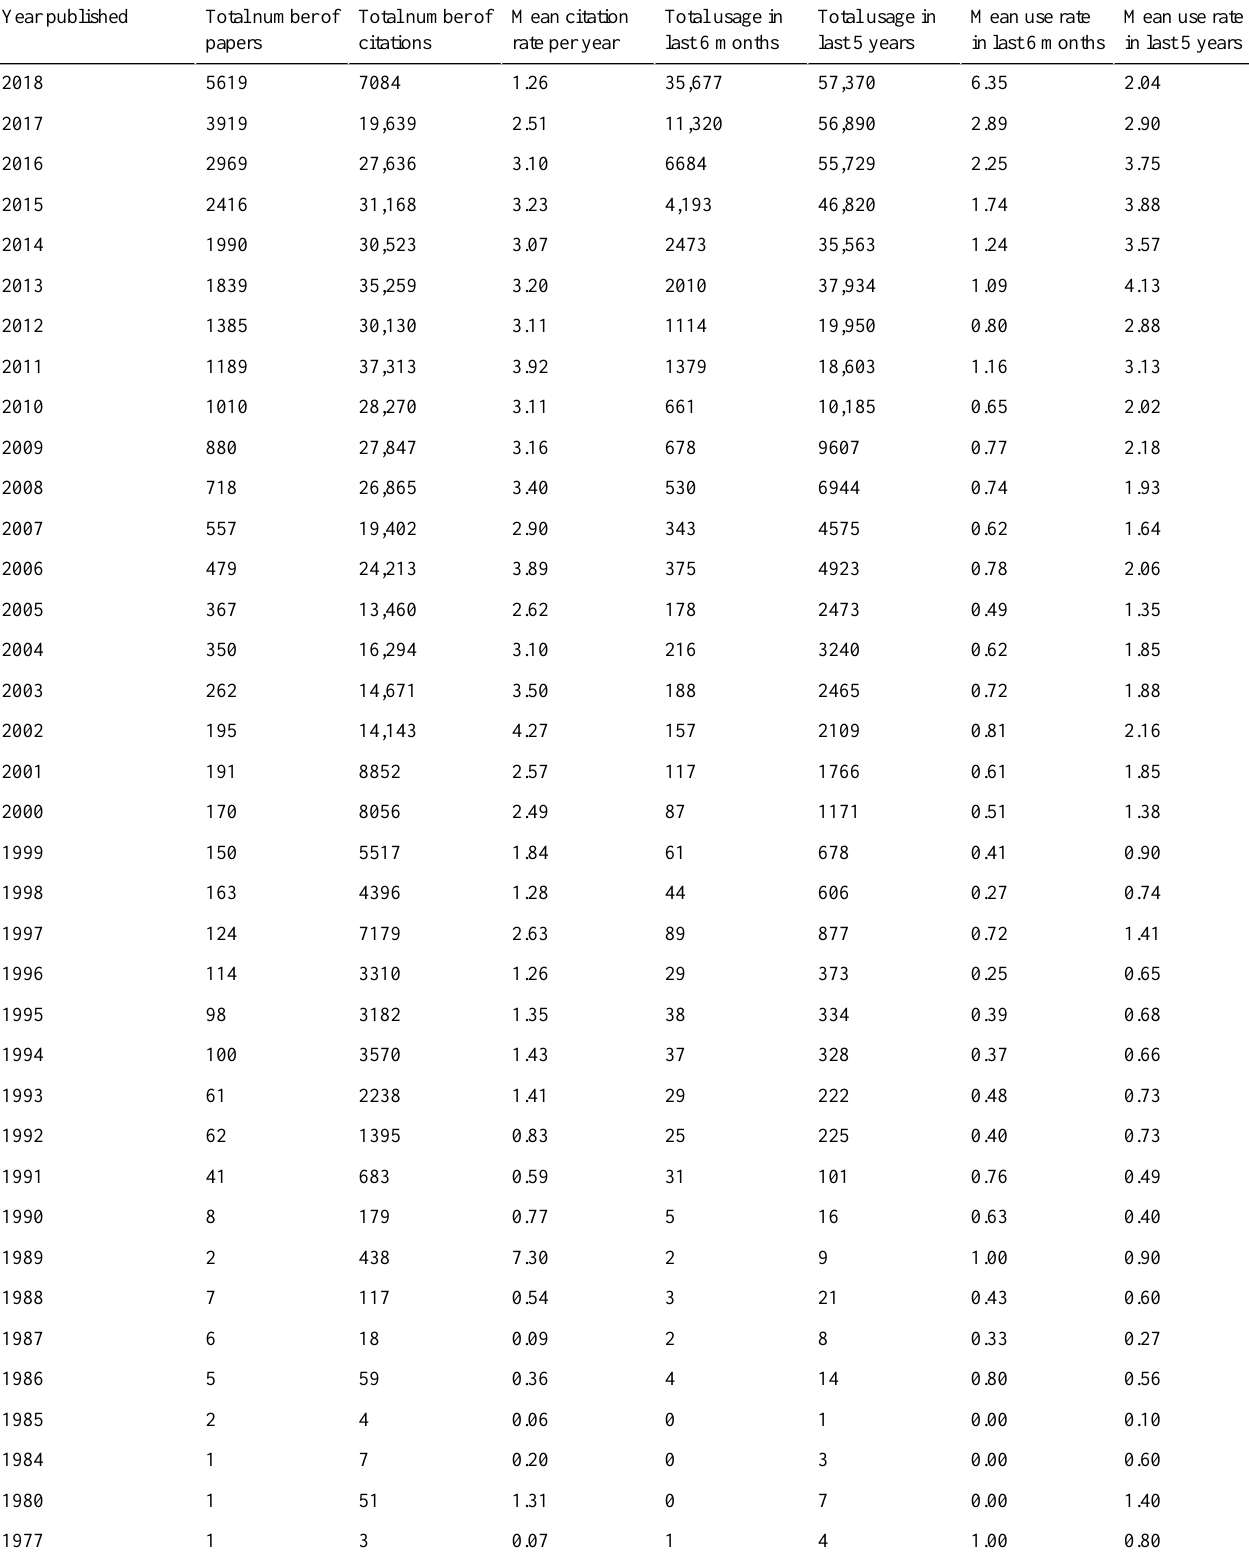
Table 2. General characteristics of